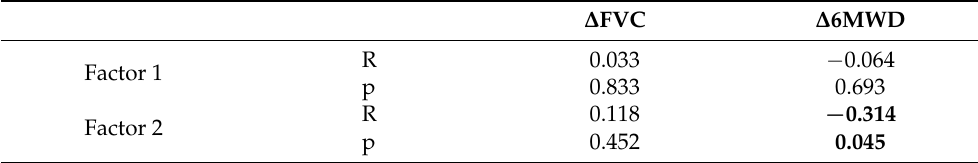
Table 8. Correlations between Factors and changes in FVC ( ∆ FVC) and 6MWD ( ∆ 6MWD) in the study group.